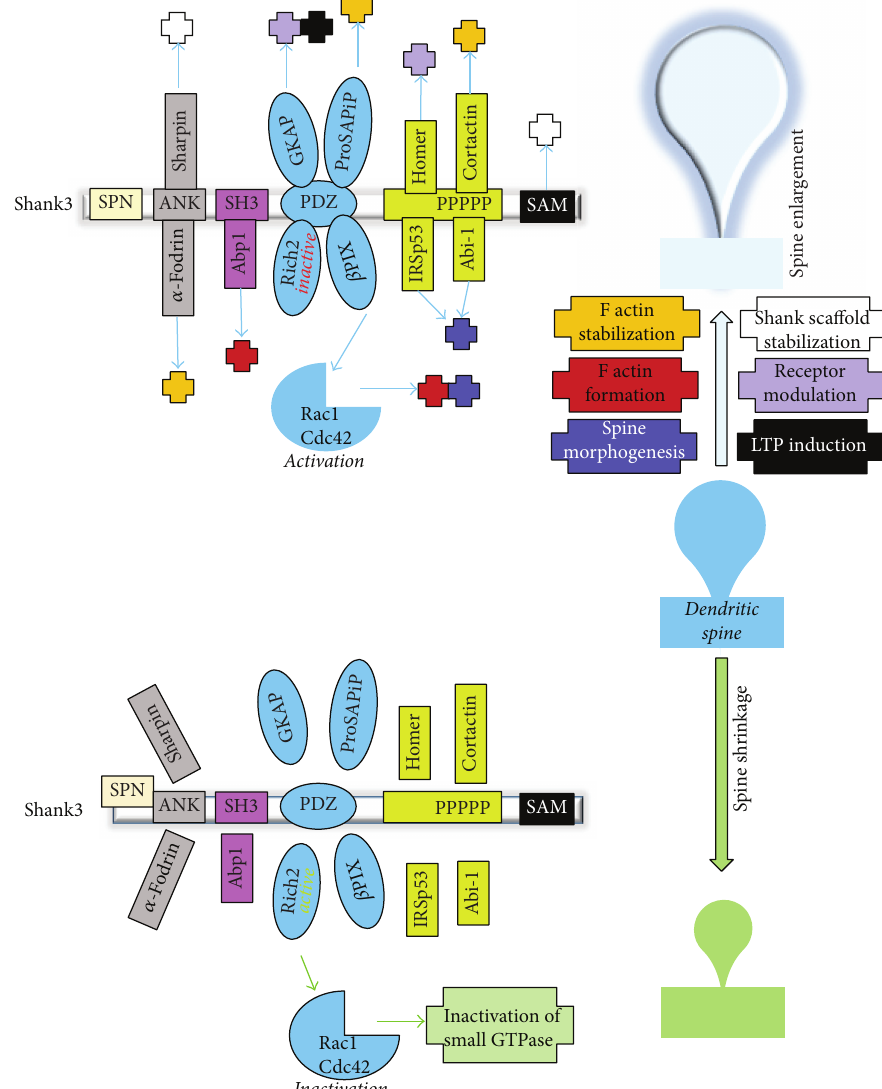
Figure 7: Shank3 and its interaction partners can affect actin cytoskeleton and spine morphology via various pathways. Shank3 and its many interaction partners can affect spine maturation and morphogenesis. Ankyrin repeat domain interaction partners, sharpin and 𝛼 -fodrin, enable spine enhancement via Shank scaffold stabilization and F actin stabilization. SH3 domain interaction partner, Abp1, enhances F actin formation. Other scaffolding molecules, GKAP and Homer, can interact with Shank3 and take part in AMPA, NMDA, and mGluR modulation. Small GTPase modulator like 𝛽 PIX activates Rac1 and/or Cdc42 and enables F actin formation and spine morphogenesis. Cortactin, intertion partner of proline-rich domain, binds and stabilizes F actin. Thus, most of the Shank3 interaction partners have a positive roleinspinemorphogenesisandmutationsordeletionsresultinspineshrinkageandlossofsynapses.AnexceptionisRich2.Rich2deactivates Rac1 and/or Cdc42 and thus can take part in spine size reduction and spine loss. Shank3 bound Rich2 is inactive. Therefore, a switch between Shank3/Rich2 to Shank3 and unbound Rich2 at the PSD may be an important integrator of the translation of synaptic activity in controlled and restricted spine growth. It is mentionworthy that, at any certain time point, only one interaction partner of the same domain can bind with